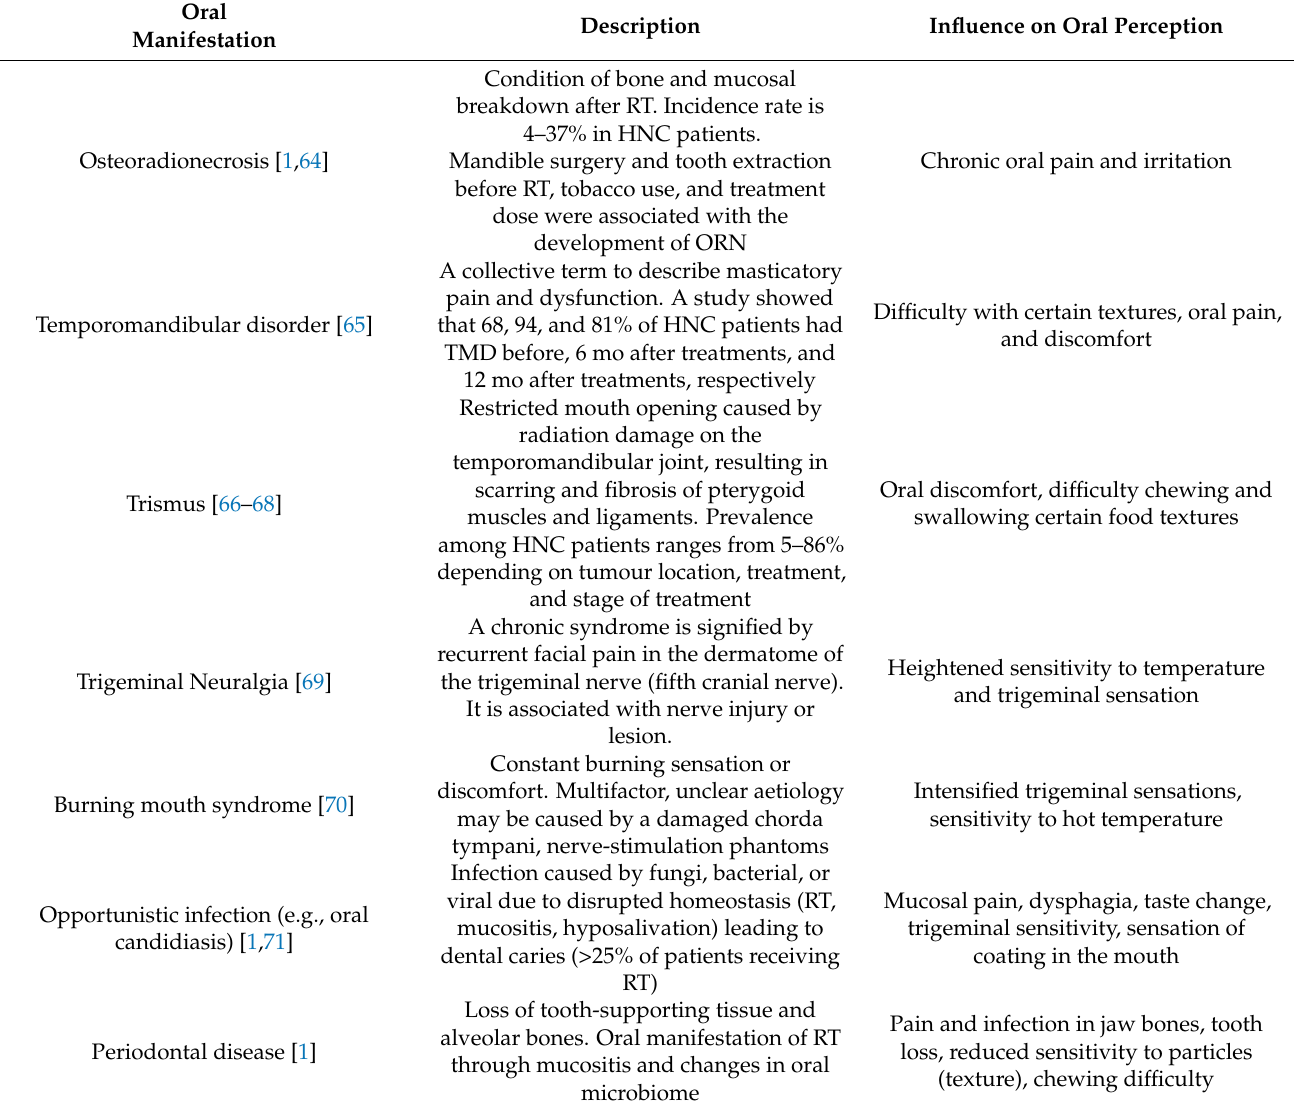
Table 3. Summary of other oral complications influencing oral somatosensory